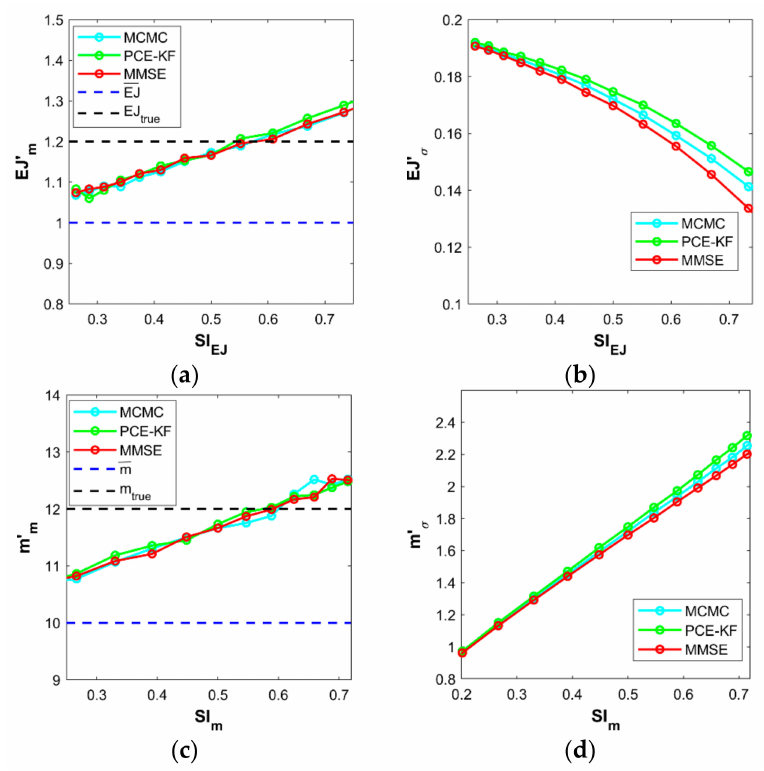
Figure 13. Posterior modes and standard deviations of EJ and m considering the variation in sensitivities ( SI EJ and SI m ): ( a ) posterior mode EJ (cid:48) m , ( b ) posterior standard deviation EJ (cid:48) σ , ( c ) posterior mode m (cid:48) m and ( d ) posterior standard deviation m (cid:48) m . Results are compared for the MCMC method (in cyan), the PCE-KF method (in green) and the NL-MMSE method (in